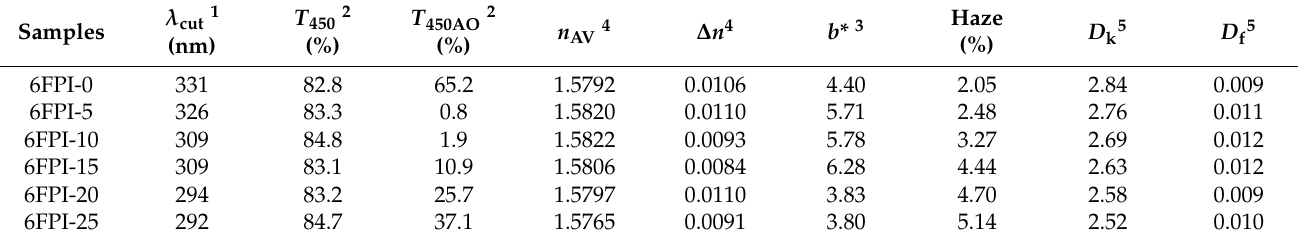
Table 2. Optical and dielectric properties of 6FPI-POSS composite films.